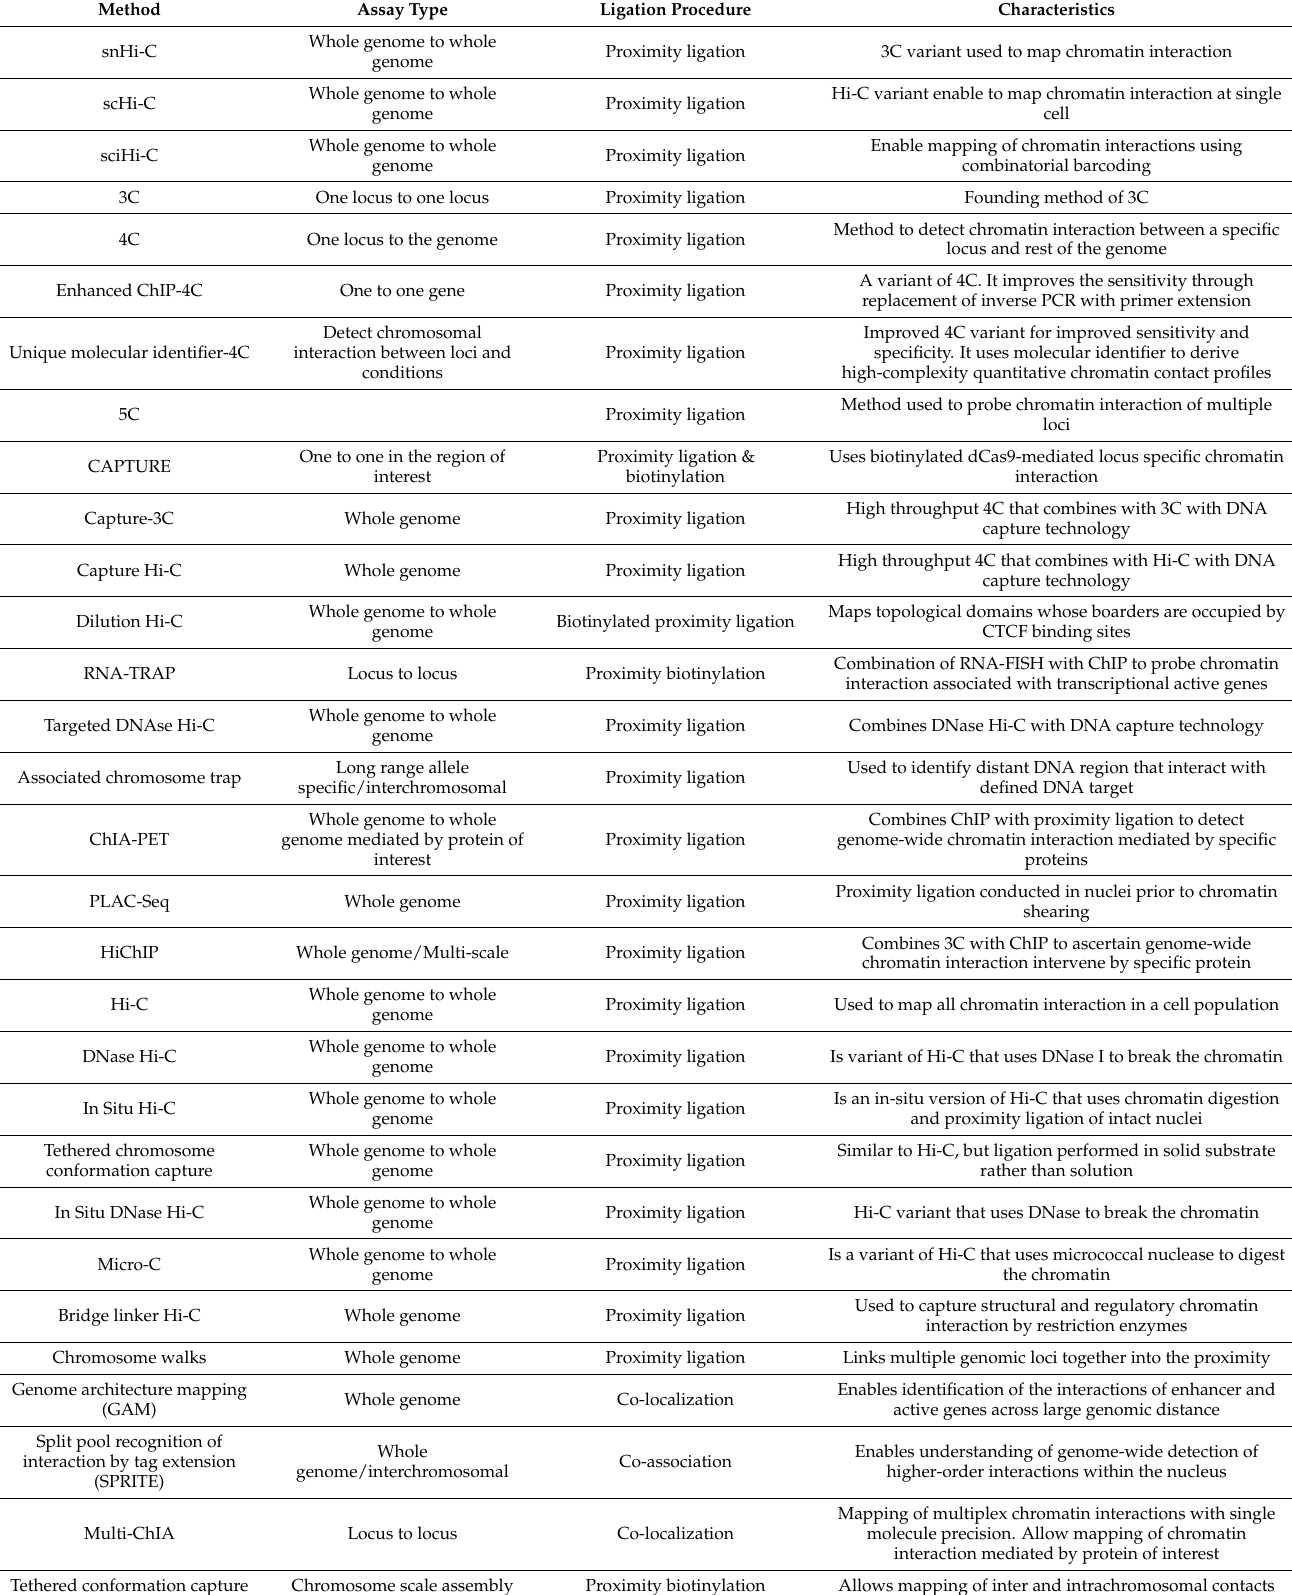
Table 1. Table representing different chromosome conformation capture method and its